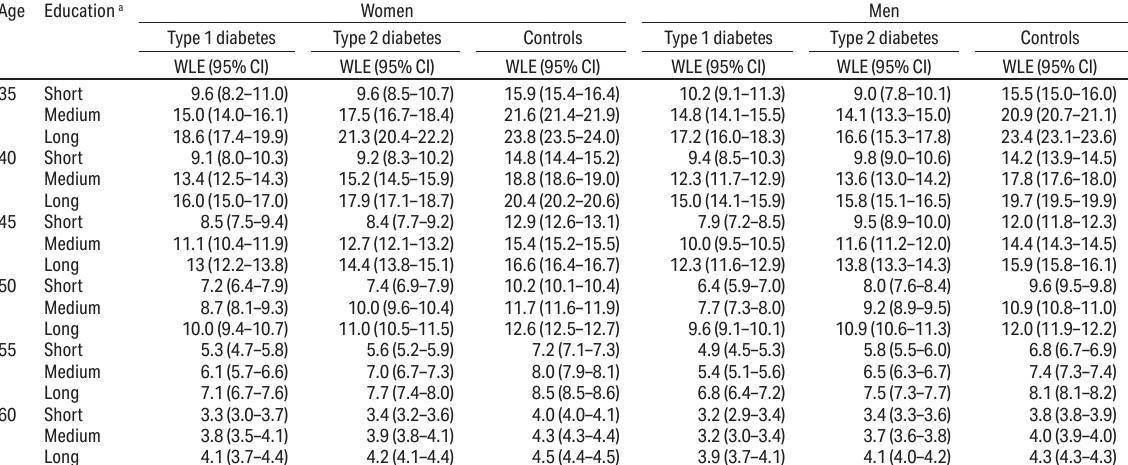
Table 2 b. Working life expectancies (WLE) in years and 95% confidence intervals (CI) of men and women living alone with type 1 and type 2 diabetes and controls, by age and